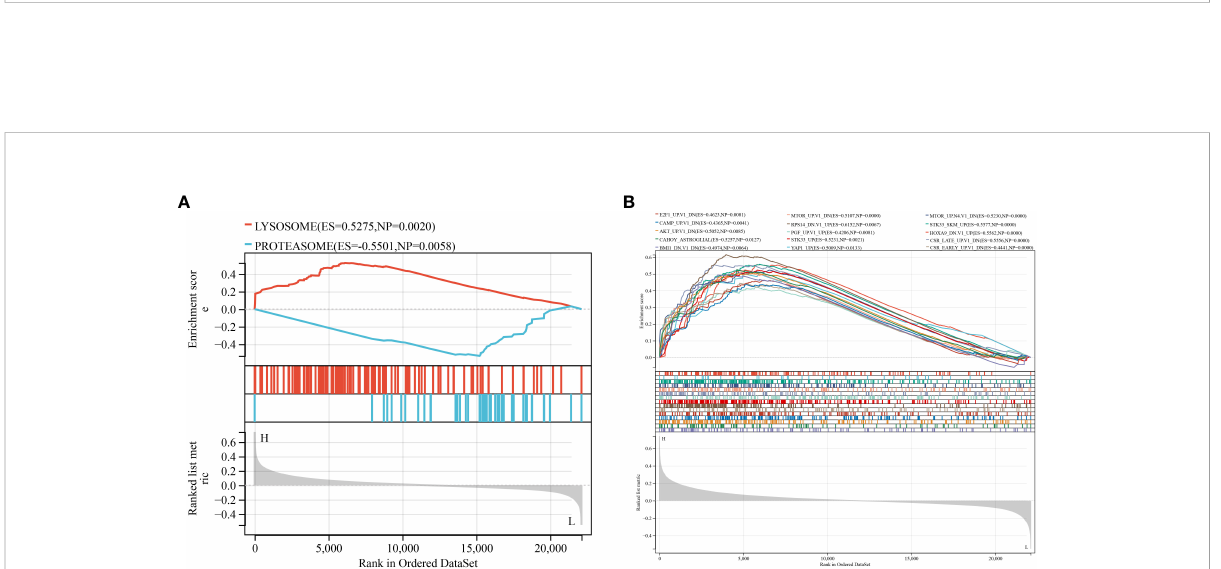
FIGURE 5 Single-gene GSEA analysis of HPGDS. (A) Enriched KEGG pathway. (B) Abundant tumor